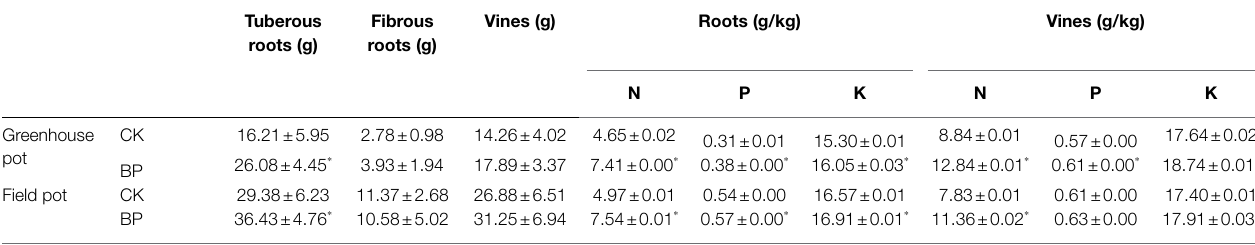
TABLE 1 | Physiological data of sweetpotato in greenhouse and field pot experiments. Tuberous Fibrous Vines (g) Roots (g/kg) Vines roots (g) roots (g)